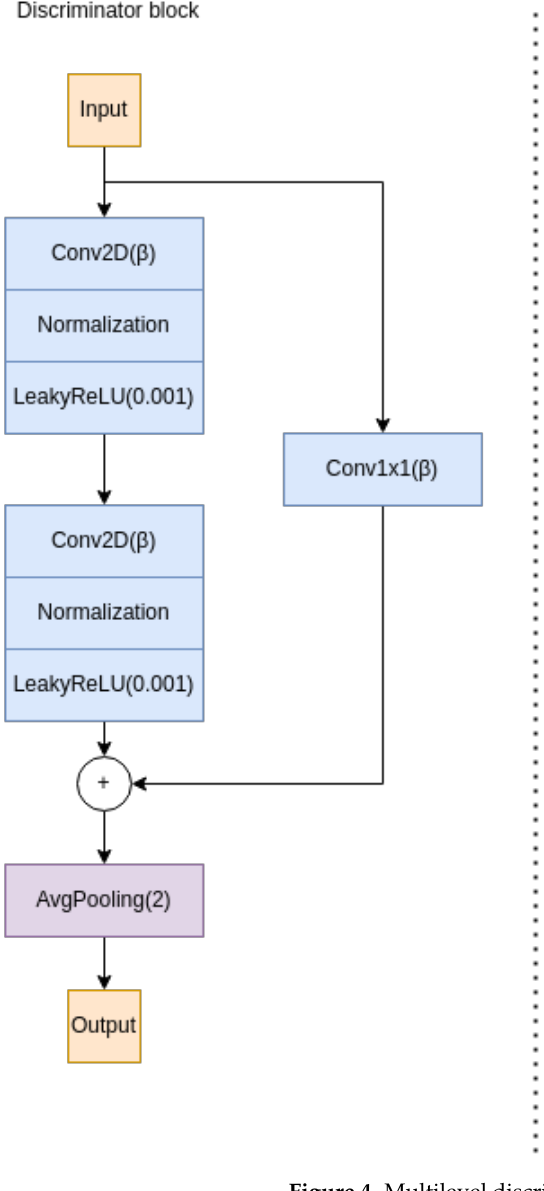
Figure 4. Multilevel discriminator architecture. This design aims to adapt features at various levels ( f 0 − f 3 ). The architecture consists of five main blocks, with the first four blocks taking as input the features at the current skip connection level and the output of the previous block. The last block is used to determine whether the features come from a source or target sample. We use a Gradient Reversal layer at each input. It is important to note that each discriminator block includes a residual skip